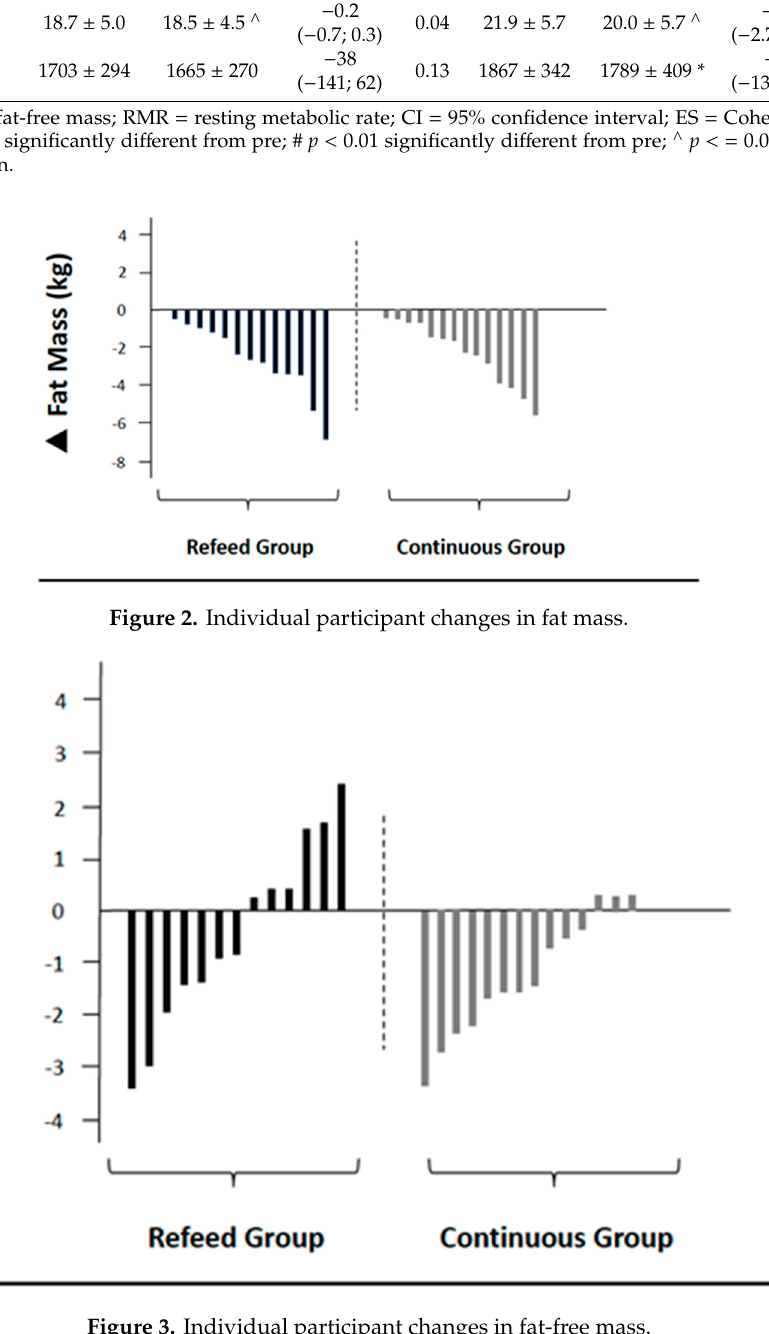
Figure 3. Individual participant changes in fat-free mass.